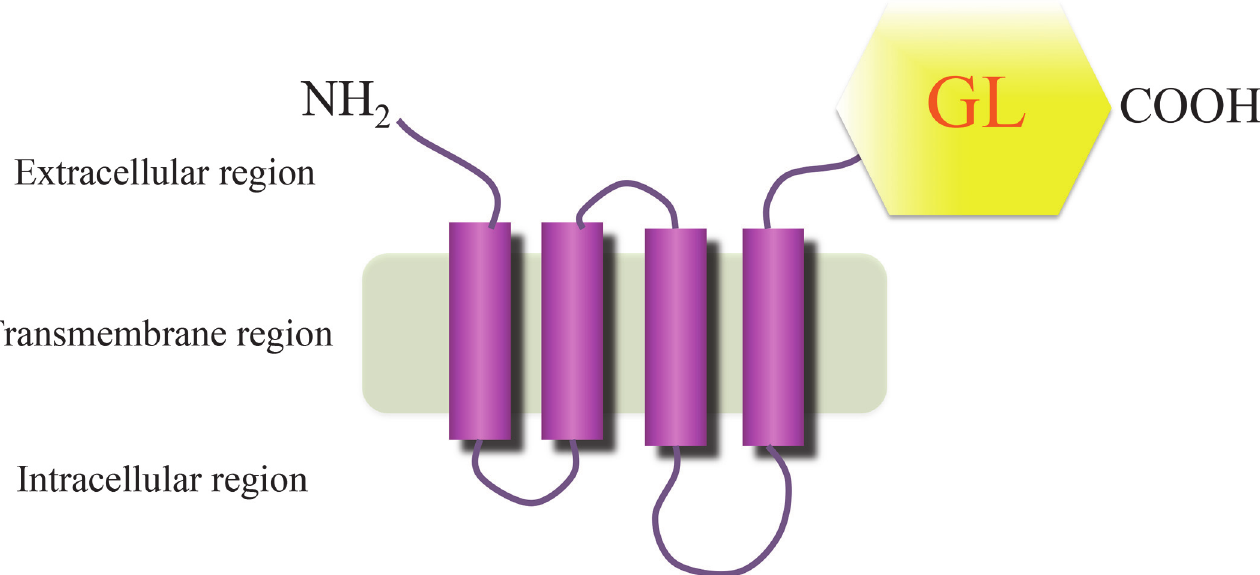
Fig 1. Schematic representation of the acetylcholine receptor (AChR) α 3- Gaussia luciferase (GL) 8990 . For the ganglionic AChR (gAChR)-LIPS assay, human embryonic kidney (HEK) 293 cells were transfected with an expression plasmid for the gAChR α 3 or β 4-GL reporter.